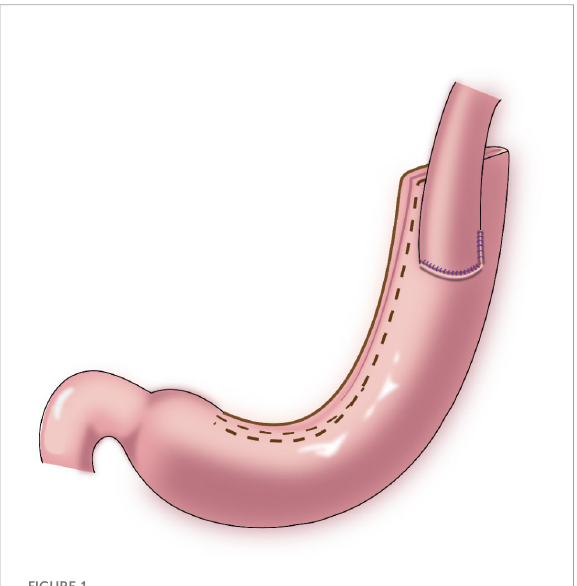
FIGURE 1 Tubular gastroesophagostomy: the esophagus was